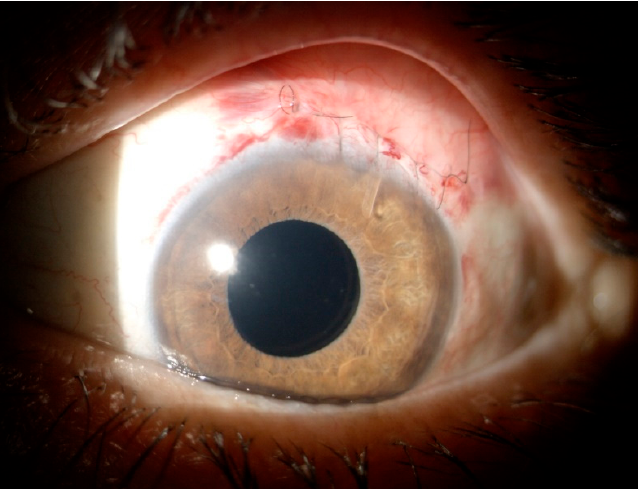
Figure 3. PreserFlo MicroShunt the day after surgical implant. Pretty visible tube in the anterior chamber, sutures over the conjunctiva and the forming filtering bleb.